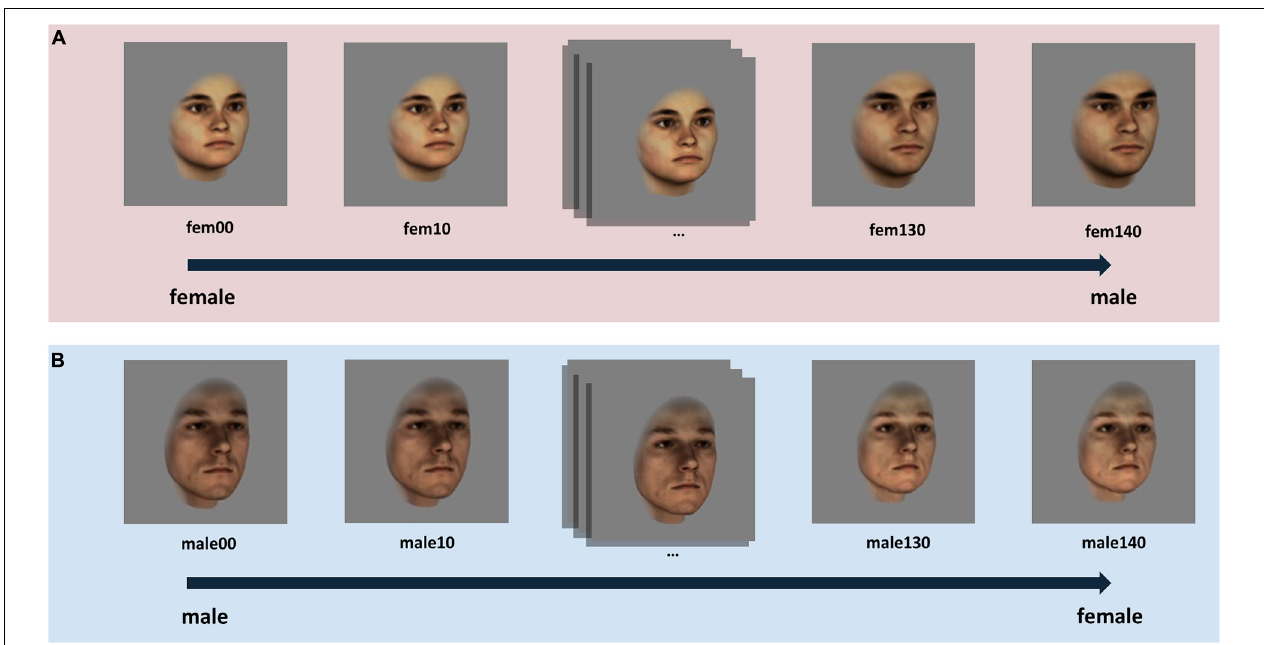
FIGURE 1 | Illustration of the morphing procedure for (A) original female face identities and (B) for original male face identities, exemplified by means of one female and one male identity. The image captioned “fem00” represents a “superfemale” image which was created by feminizing the original face scan (fem40) of the corresponding female identity. Both the original female face (fem40) and the original male face (male00) were morphed in 10% – intervals along the sex morph continua, created based on a sex vector, to the opposite-sex version endpoint face.